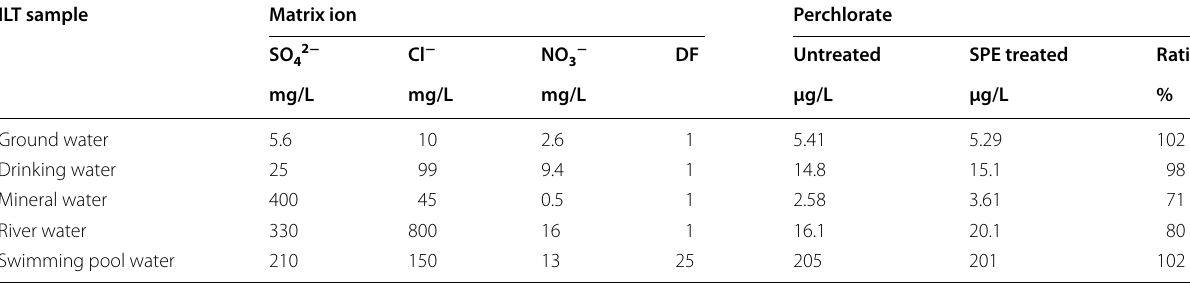
DF sample dilution factor applied, Ratio (Untreated/SPE treated)∙100%